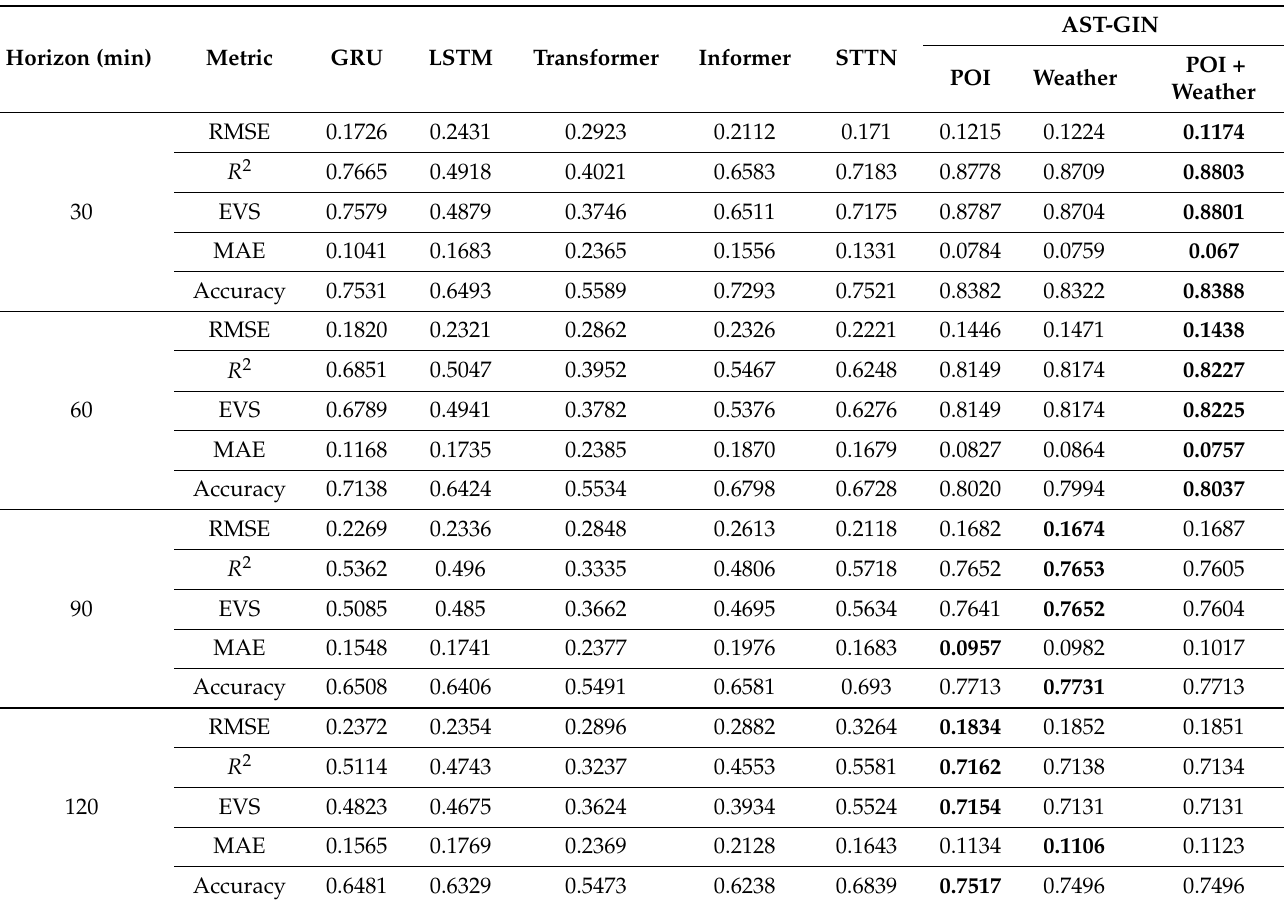
Table 1. Forecasting results of the AST-GIN and baseline